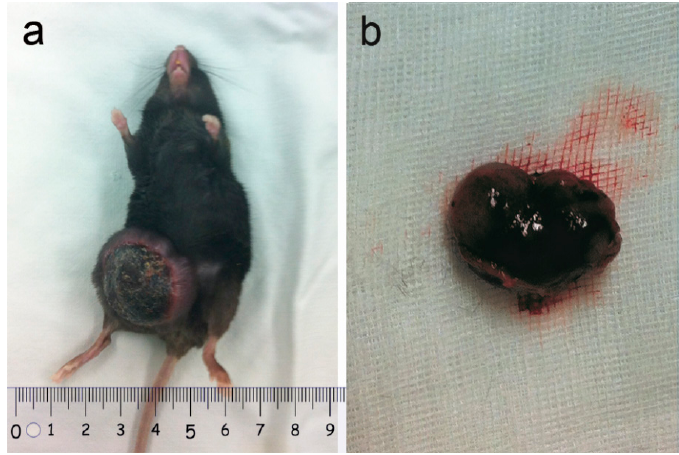
Figure 1. Tumor observation: ( a ) All recipients developed nodular neoplasms; ( b ) Each tumor showed single or coupled nodular features with a large volume.